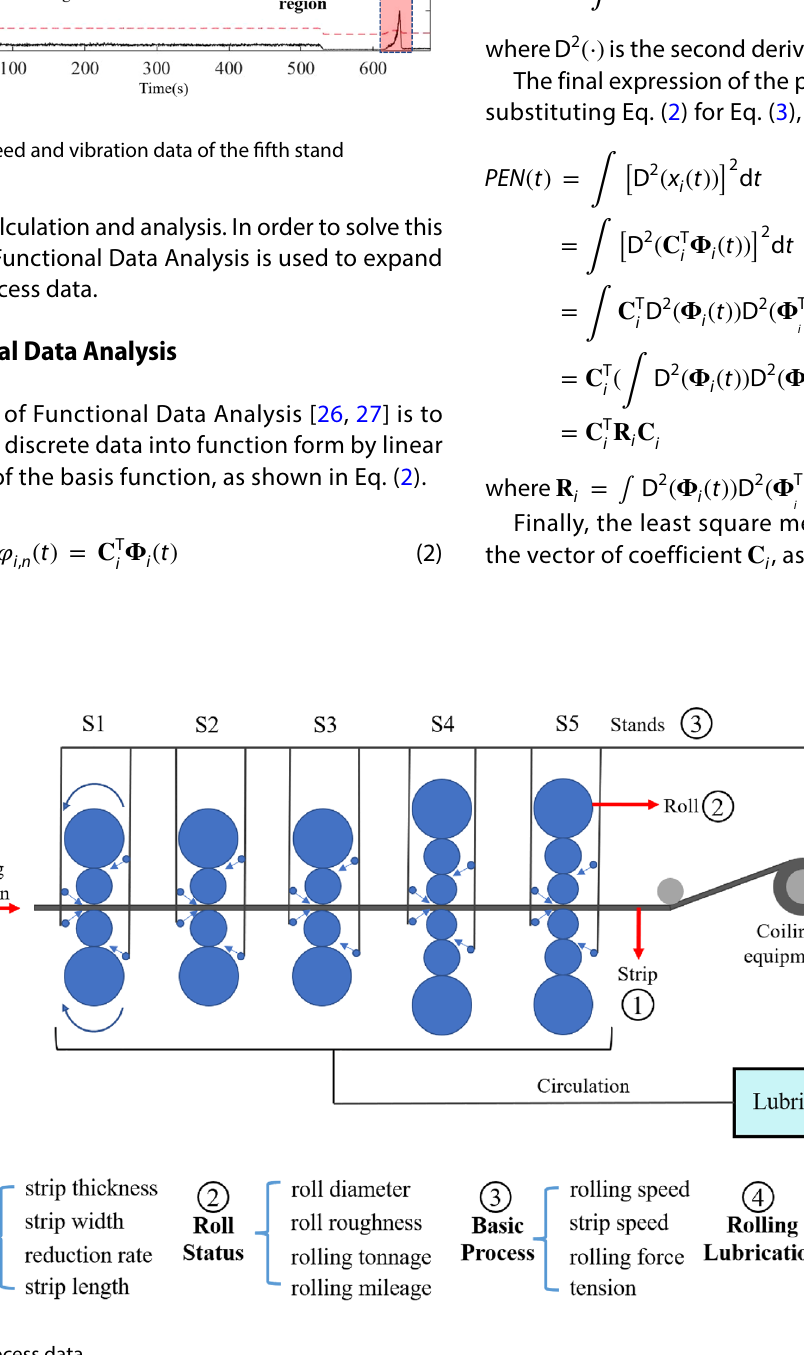
Fig. 3 Rolling process